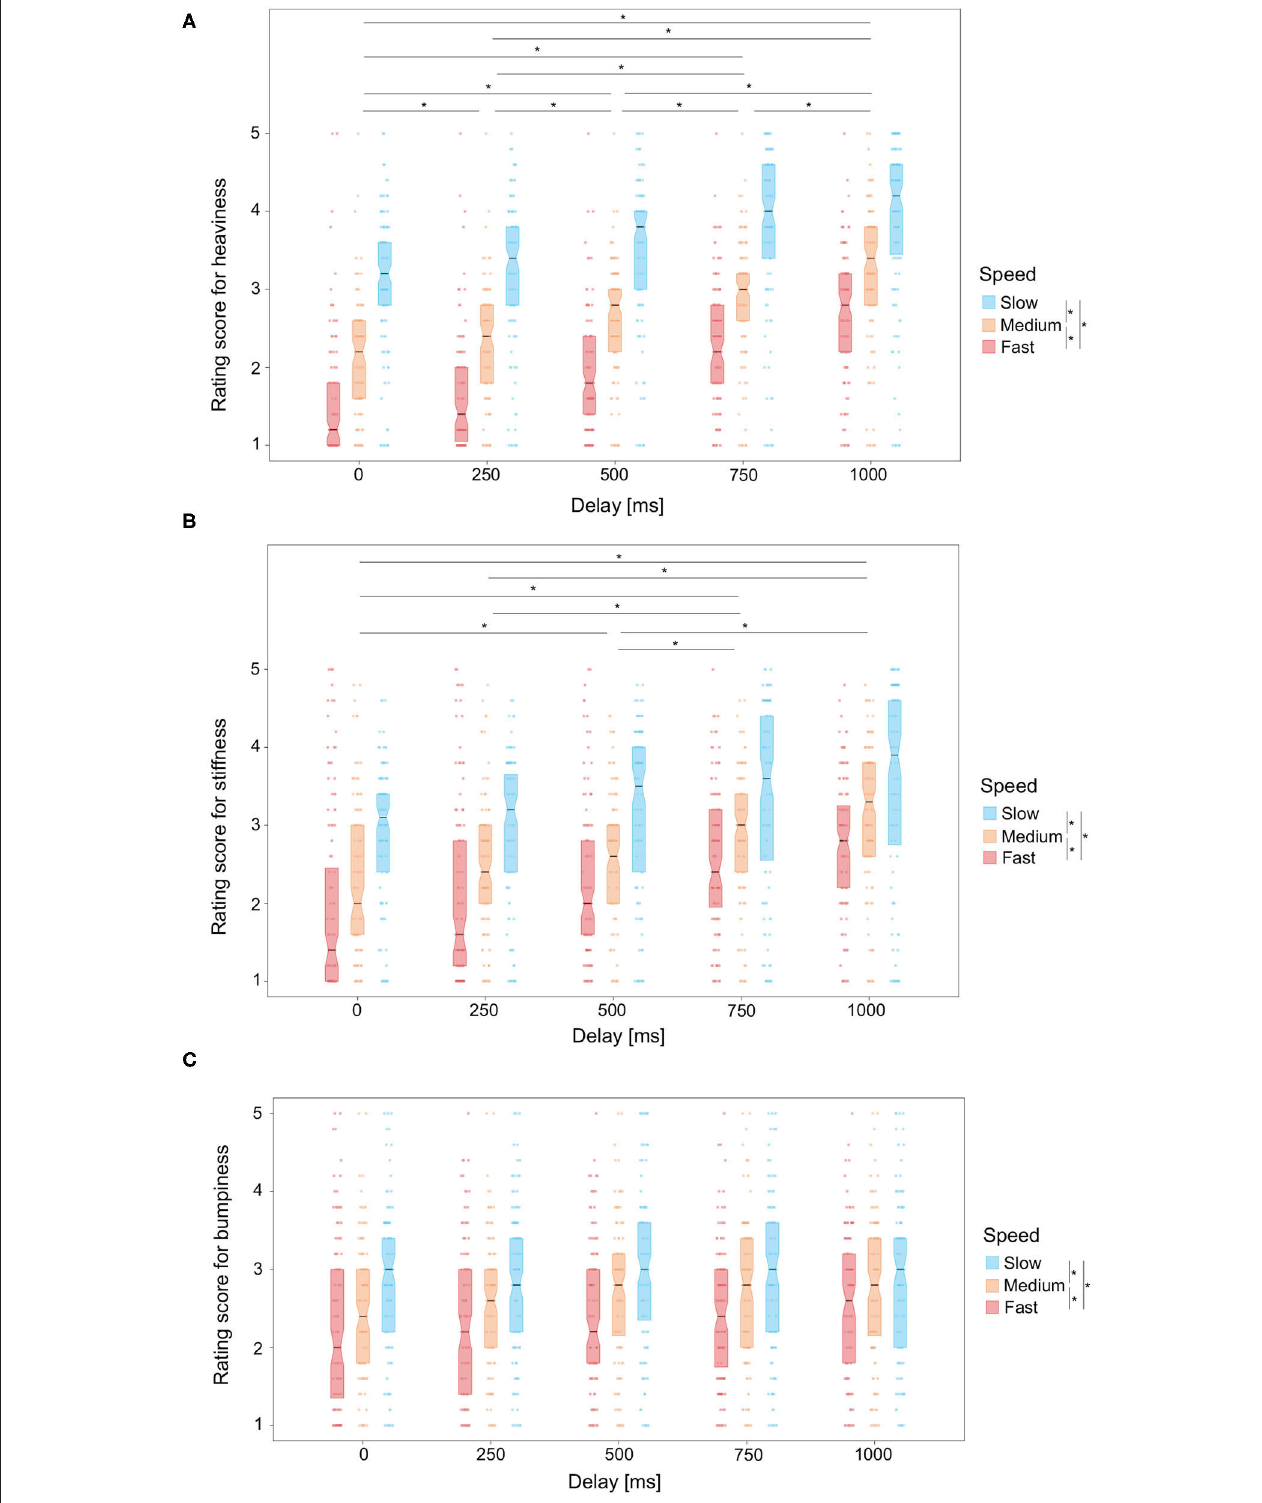
FIGURE 2 | Experiment 1 results. Box plots of (A) heaviness rating scores, (B) stiffness rating scores, and (C) bumpiness rating scores for each of the speed conditions as a function of the delay. Asterisks denote the pairs for which the means were significantly different using the EcolUtils package (Bonferroni-corrected p <